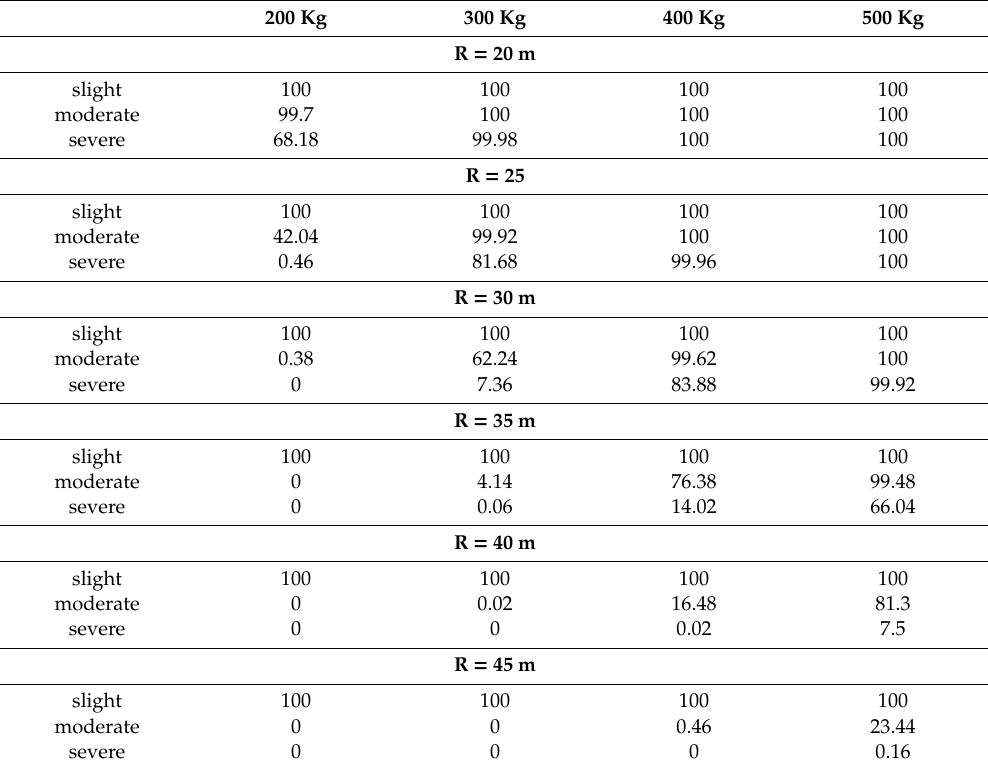
Table 9. Percentage probability of thresholds exceedance for Bari location.